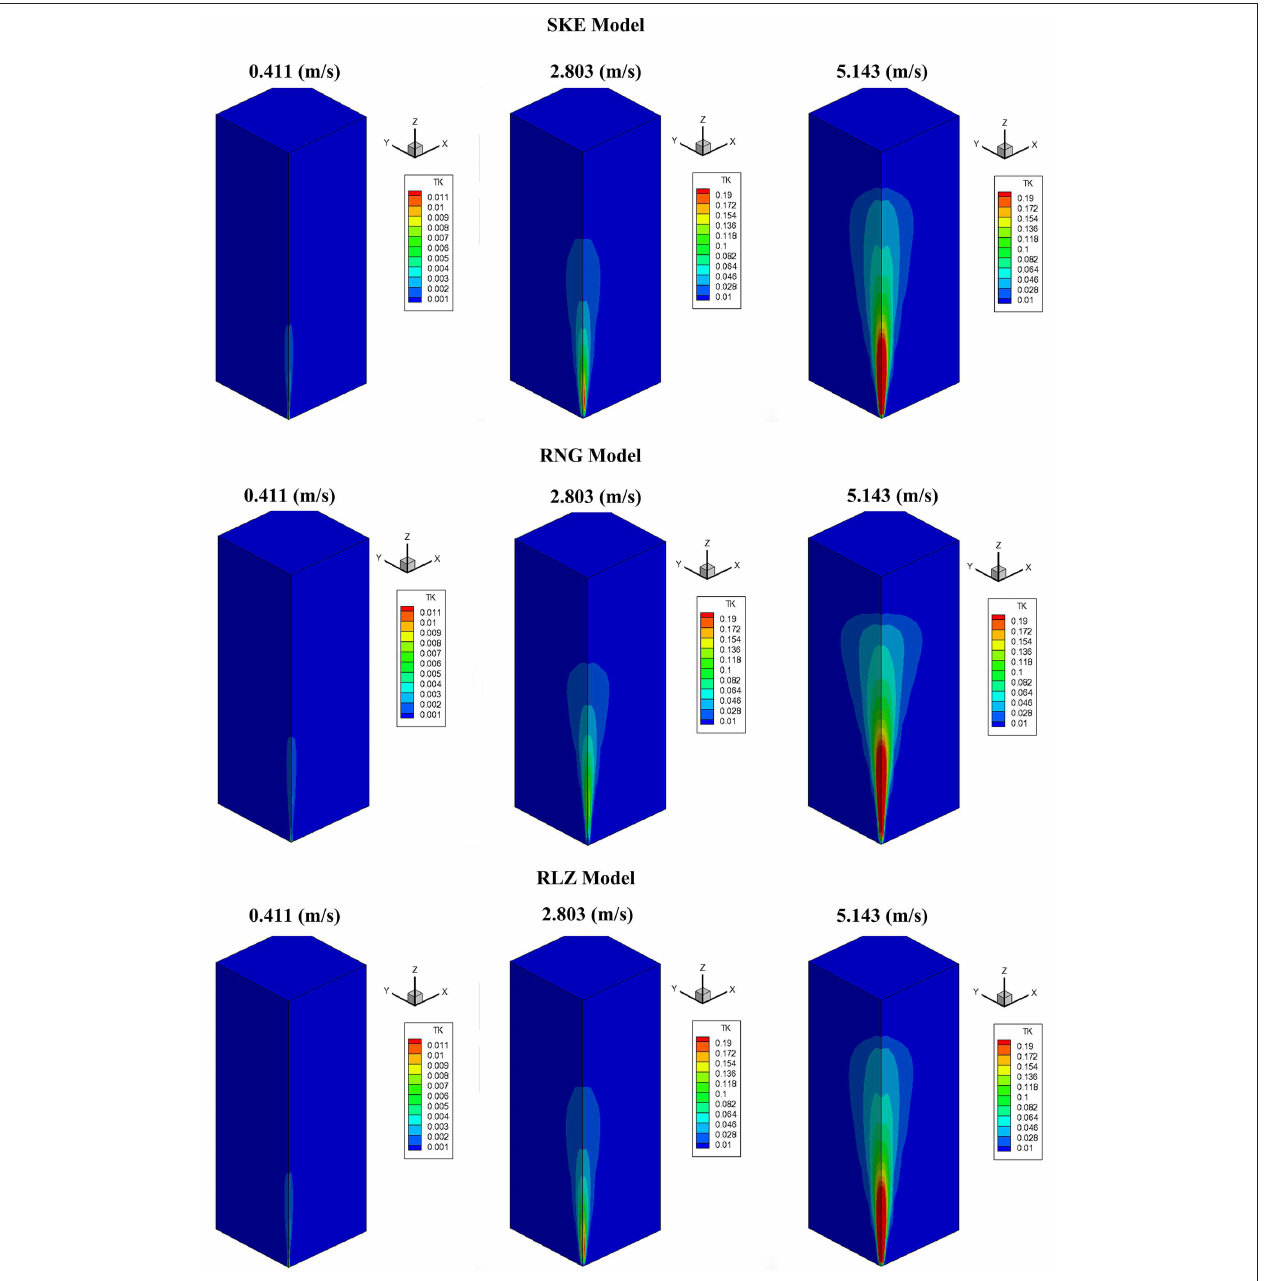
FIGURE 10 | Comparison of instantaneous turbulence kinetic energy (m 2 /s 2 ) calculated by three various air-injection velocities for SKE, RNG, and RLZ at 200 (s).